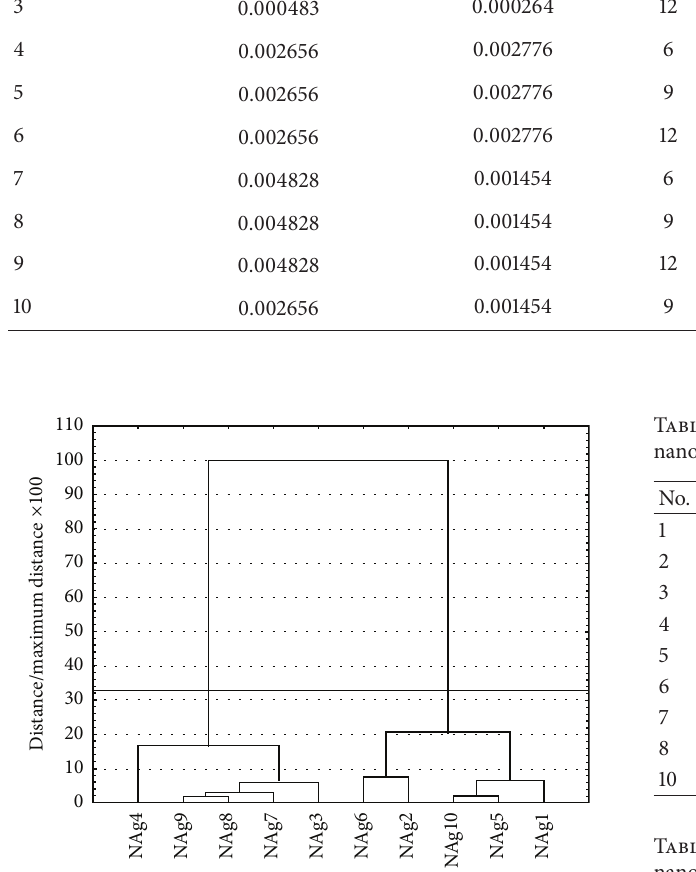
Figure 6: Hierarchical tree showing the assignment of objects (spectra of nanosilver) for each cluster.